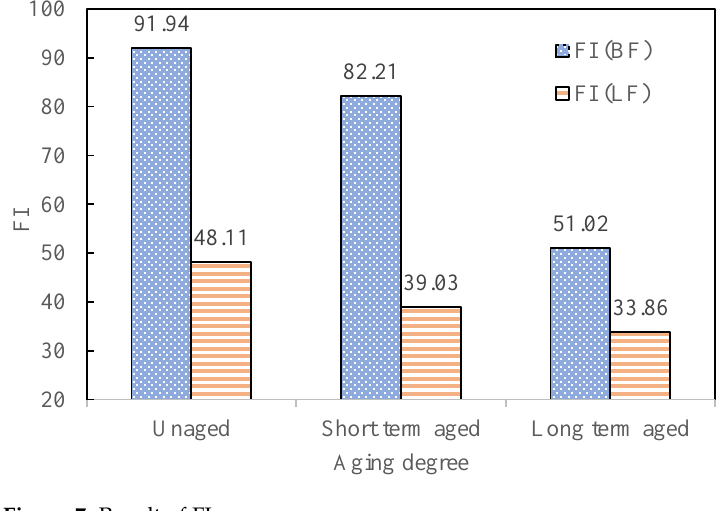
Figure 7. Result of FI.